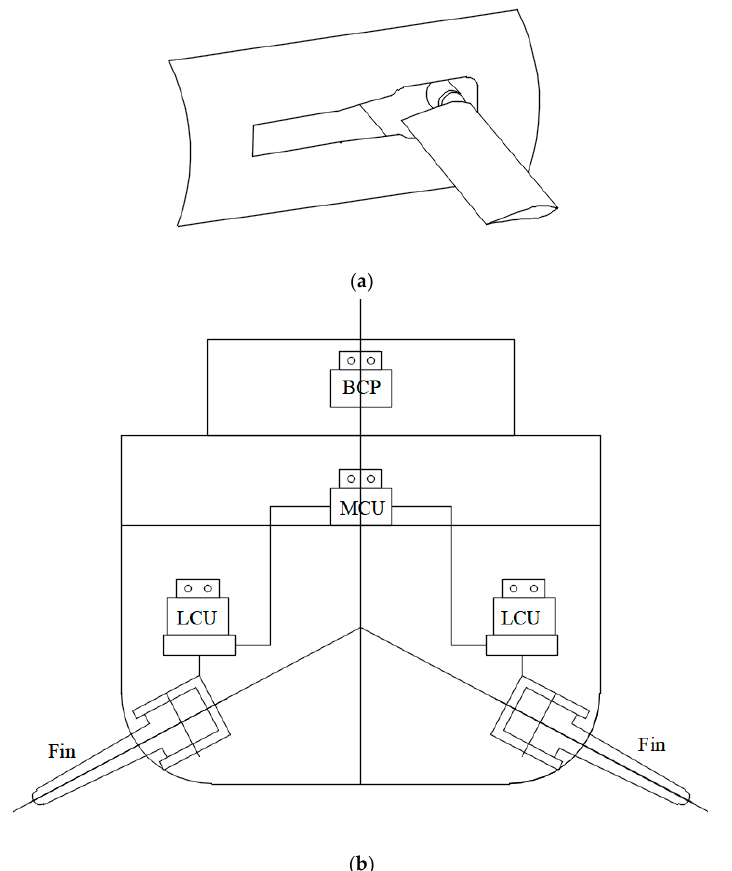
Figure 1. Retractable fin stabilizer device. ( a ) Retractable fin with fin box. ( b ) Control components for fin stabilizers.